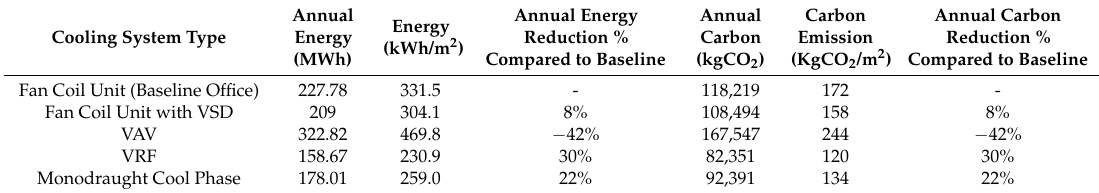
Table 14. Energy and carbon variation due to implementation of different cooling systems.